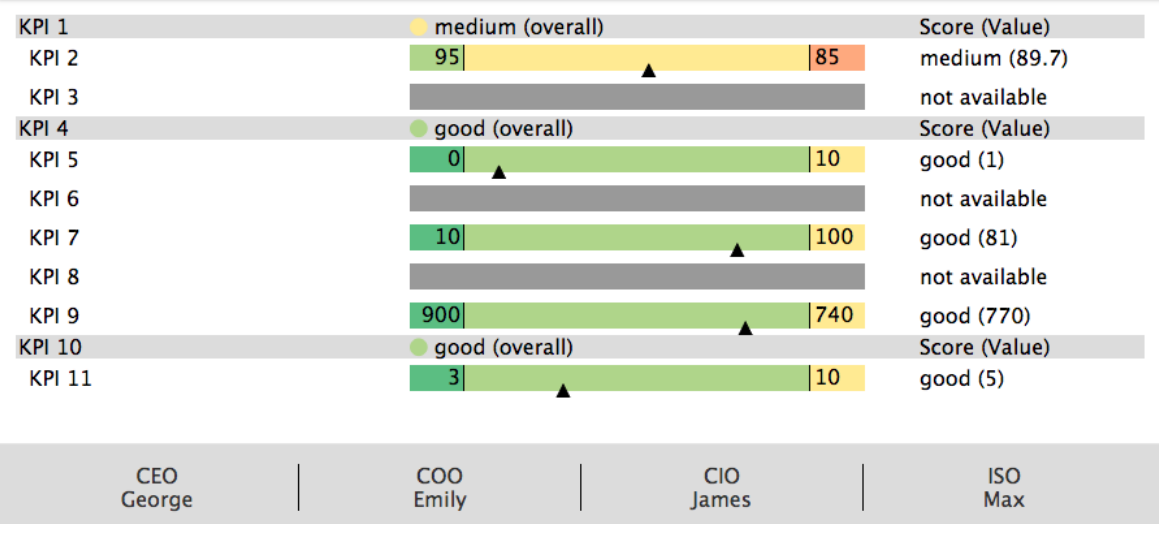
Figure 9. Detail view for the representation of an